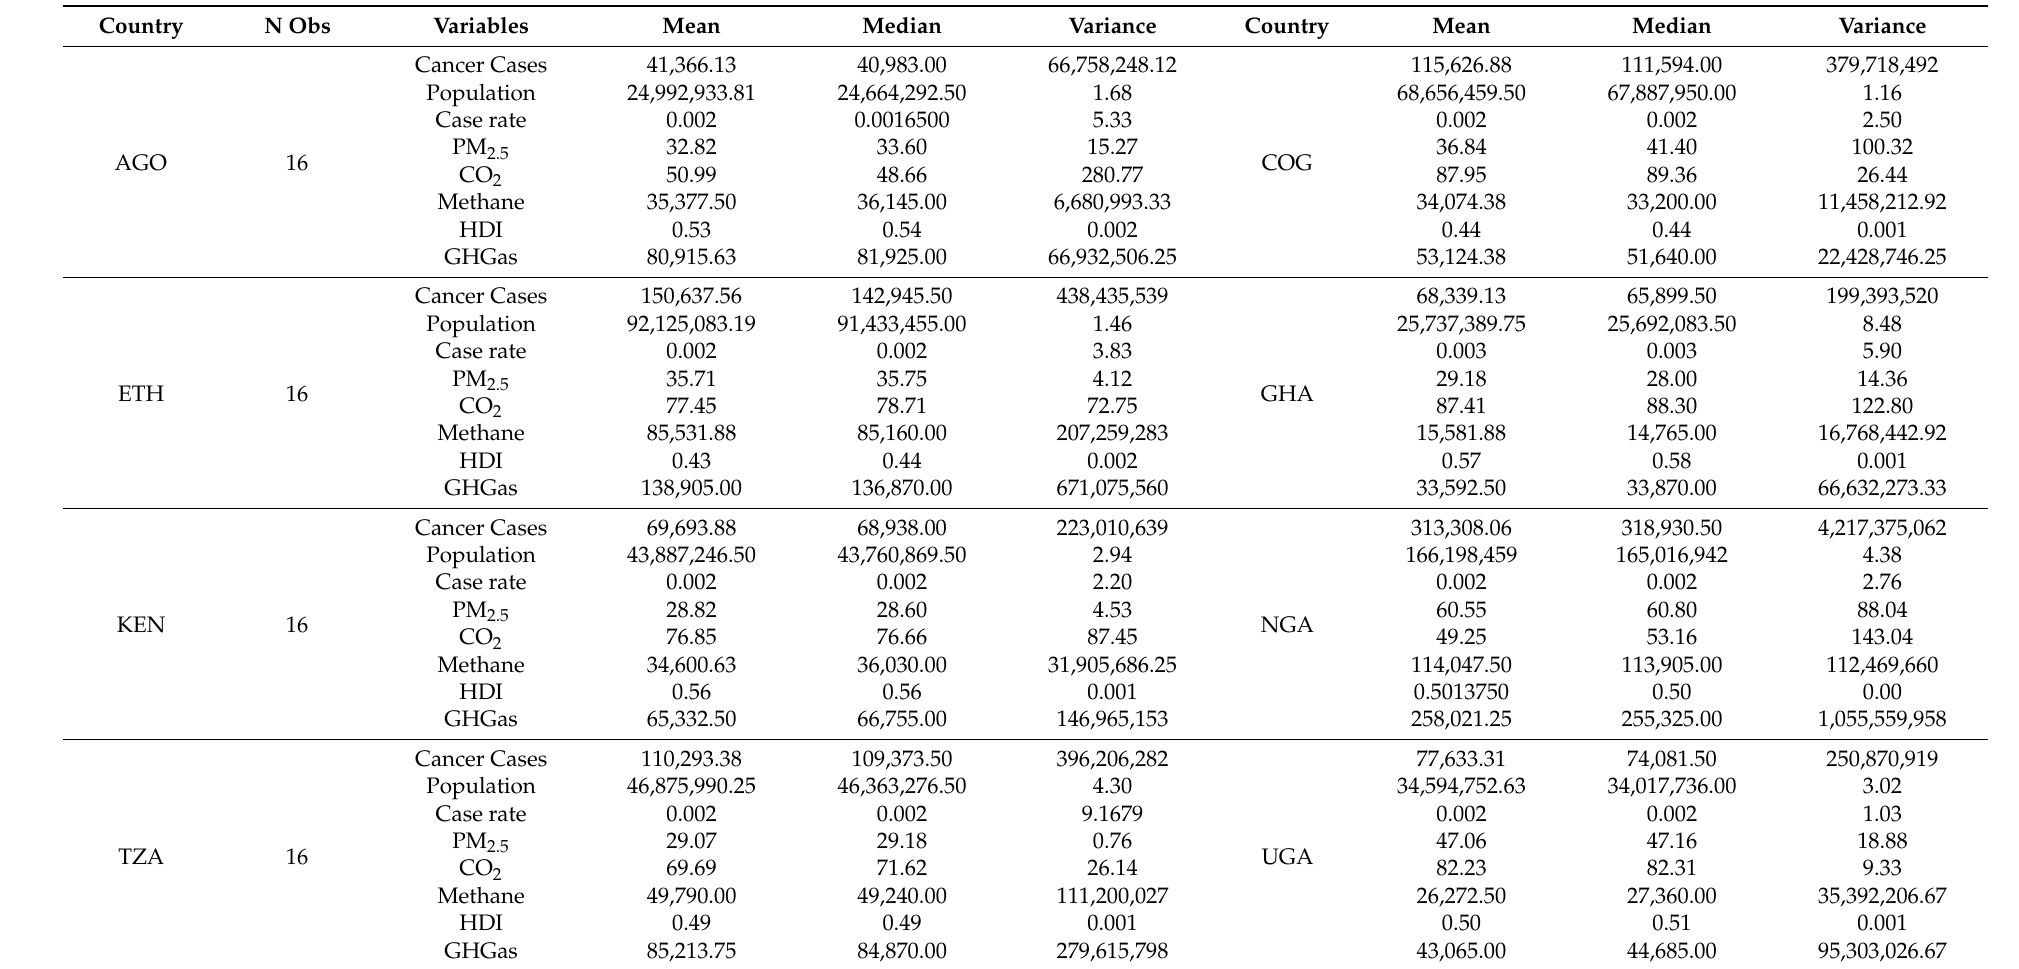
Table 3. Descriptive statistics by country using the MEANS Procedure over 16